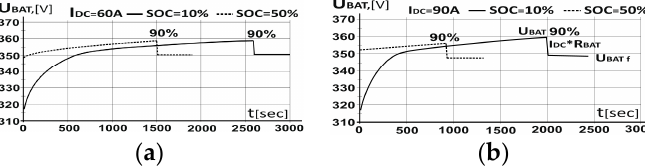
Figure 11. Charging scenario with power to the battery: ( a ) 21 kW (I DC = 60 A) and SOC 10 and 50%